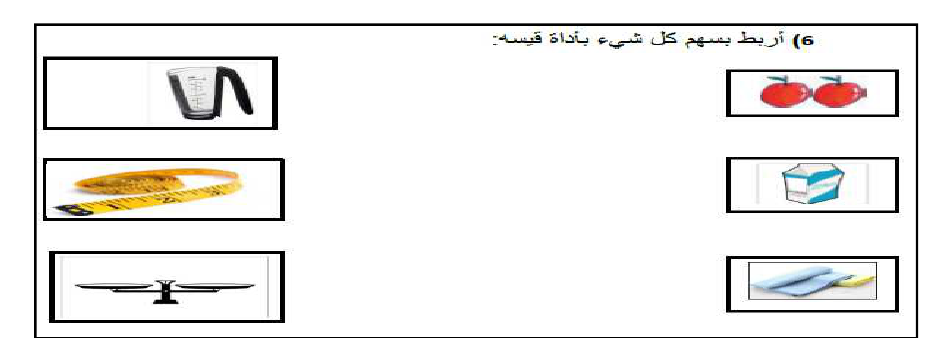
Fig. 2. La consigne du test pour évaluer la notion « l’évaluation des quantités».